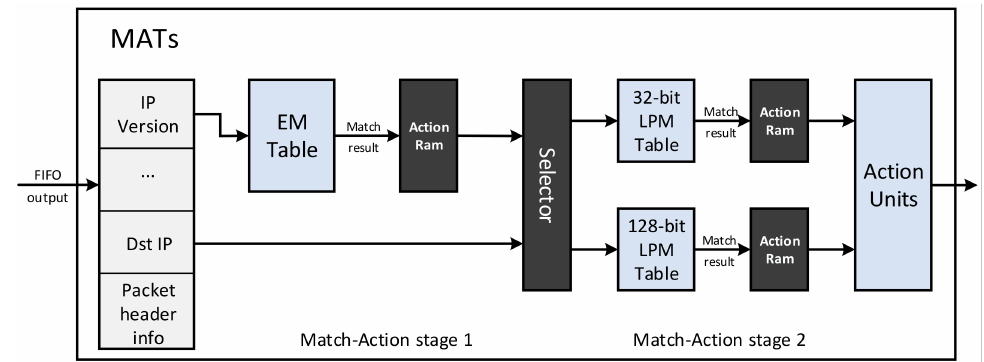
Figure 11. MA logic